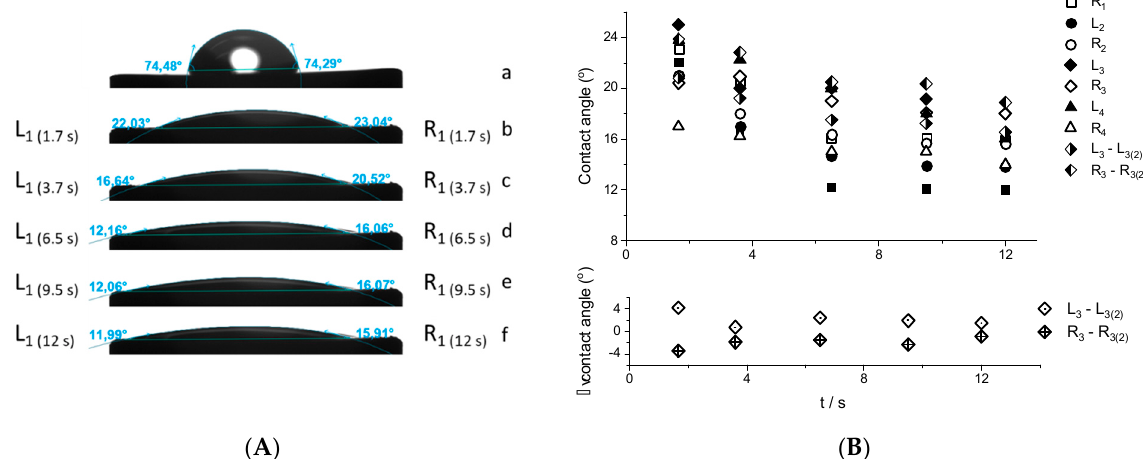
Figure 4. ( A ) Photographs illustrating the contact angle for water drops deposited onto a GC disc (a) and bismuth film plated on GC (electrode 1) (b − f). The photographs (b–f) show how the drop changed over the 12 s after deposition. ( B ) Values of left (L 1 , L 2 , L 3 , L 4 , and L 3(2) − second run for electrode 3) and right (R 1 , R 2 , R 3 , R 4 , and R 3(2) − second run for electrode 3) contact angles observed for four different BiF/GC electrodes (upper panel). Differences between the left (L 3 − L 3(2) ) and right (R 3 —R 3(2) ) contact angles values observed in the first and second run for electrode 3 (lower panel).